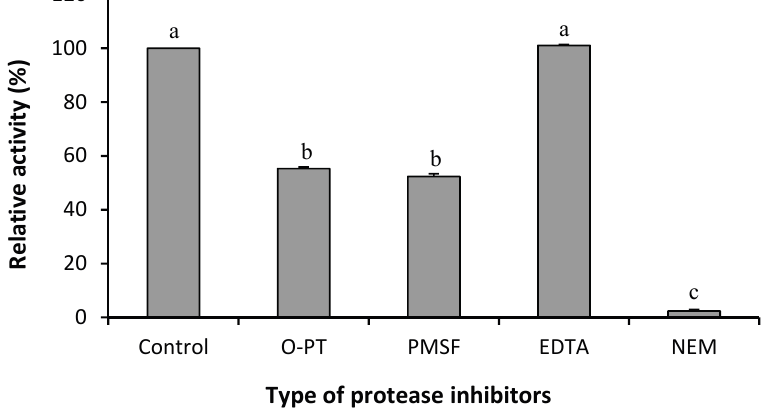
Figure 2. Effect of inhibitors on the activity of Bentong ginger protease. O -PT: o -phenanthroline; PMSF: Phenylmethylsulfonyl fluoride; EDTA: Ethylenediamine tetra-acetic acid; NEM: N -ethylmaleimide. Different superscripts indicate significant difference ( p ≤